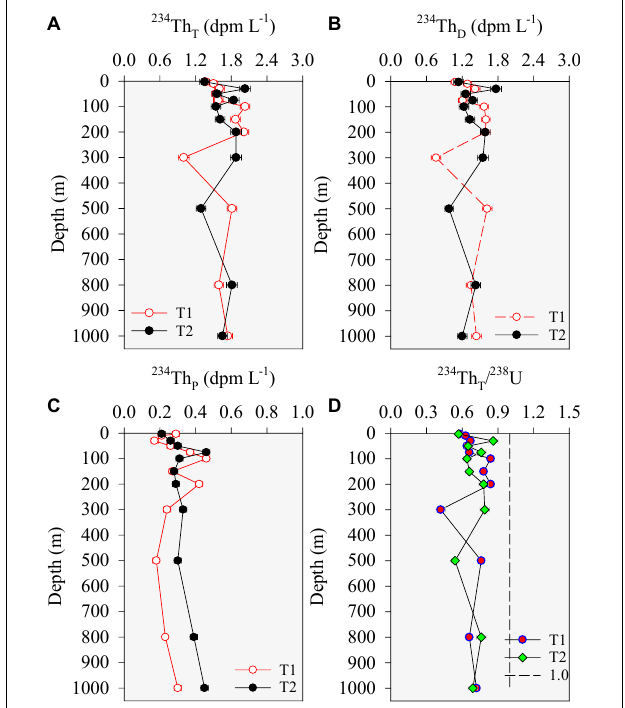
FIGURE 3 | Profiles of activity concentrations of total 234 Th (A) , dissolved 234 Th (B) , and particulate 234 Th (C) , and the activity ratios of total 234 Th to 238 U (D) at stations T1 and T2.